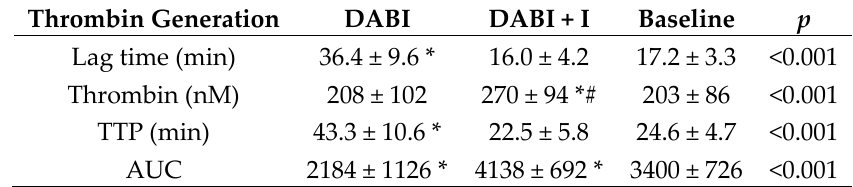
Table 1. Thrombin generation in “ex vivo” samples with dabigatran (DABI), after the addition of idarucizumab (DABI+I) and baseline samples. Means ± standard deviations are shown with ANOVA p